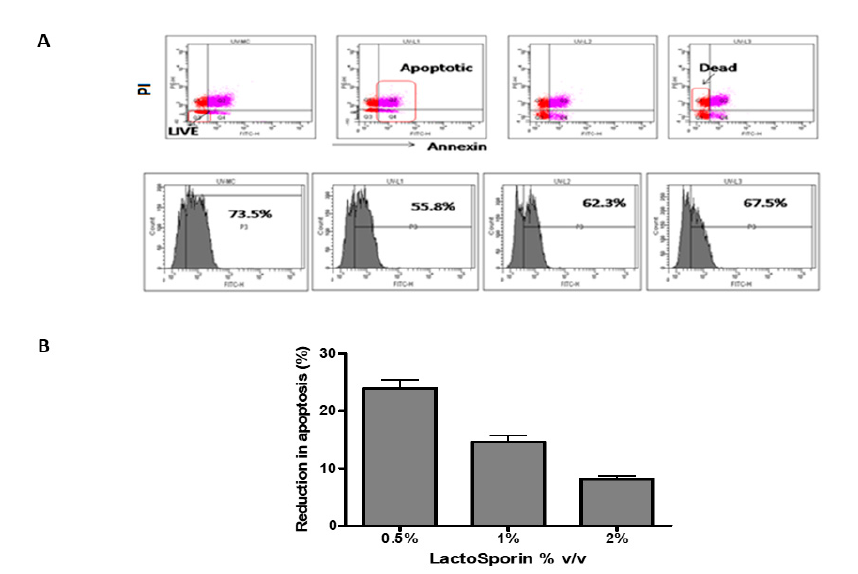
Figure 3. Protective effect of LactoSporin on UV-B-induced apoptosis. ( A ). Dot plot and histogram of UV-B exposed cells treated with LactoSporin, ( B ) Percentage reduction of apoptotic cells after LactoSporin treatment. Results are expressed as Mean ± SD (n = 3).